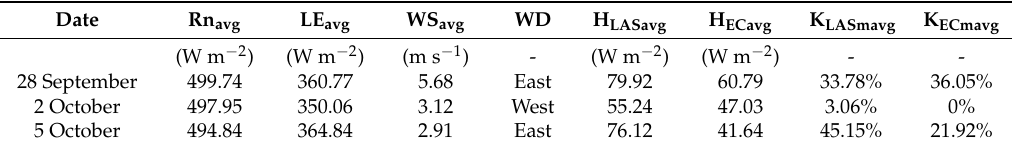
Table 2. Comparison of temporal mean (10:00–15:00) LAS-derived and EC-derived sensible heat fluxes with different weather and footprint conditions on some sunny days. The mean value of net